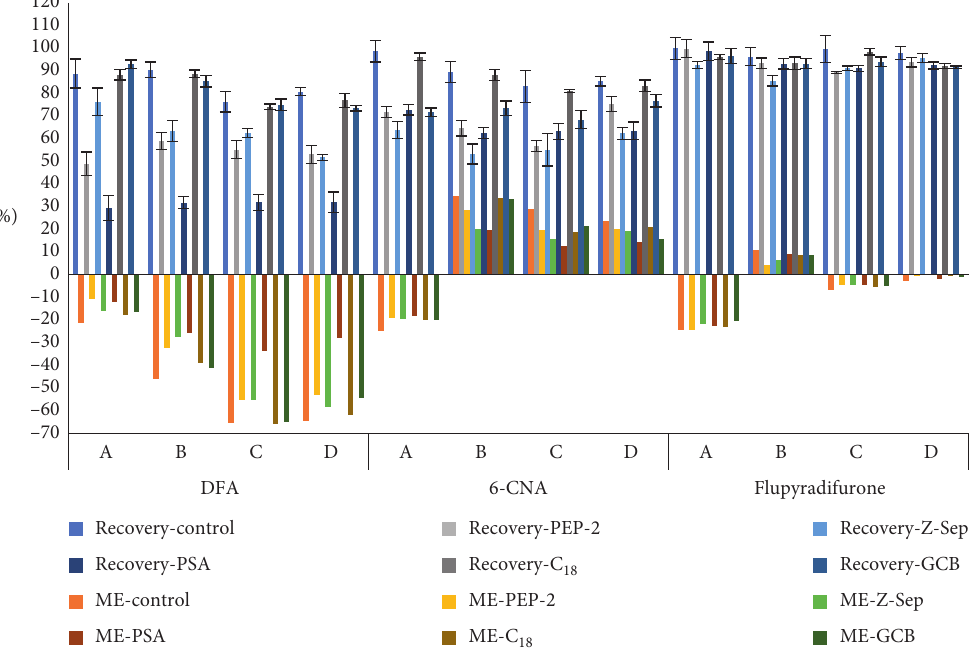
Figure 5: Recovery and ME of flupyradifurone, DFA, and 6-CNA for the method using different sorbents ( n �